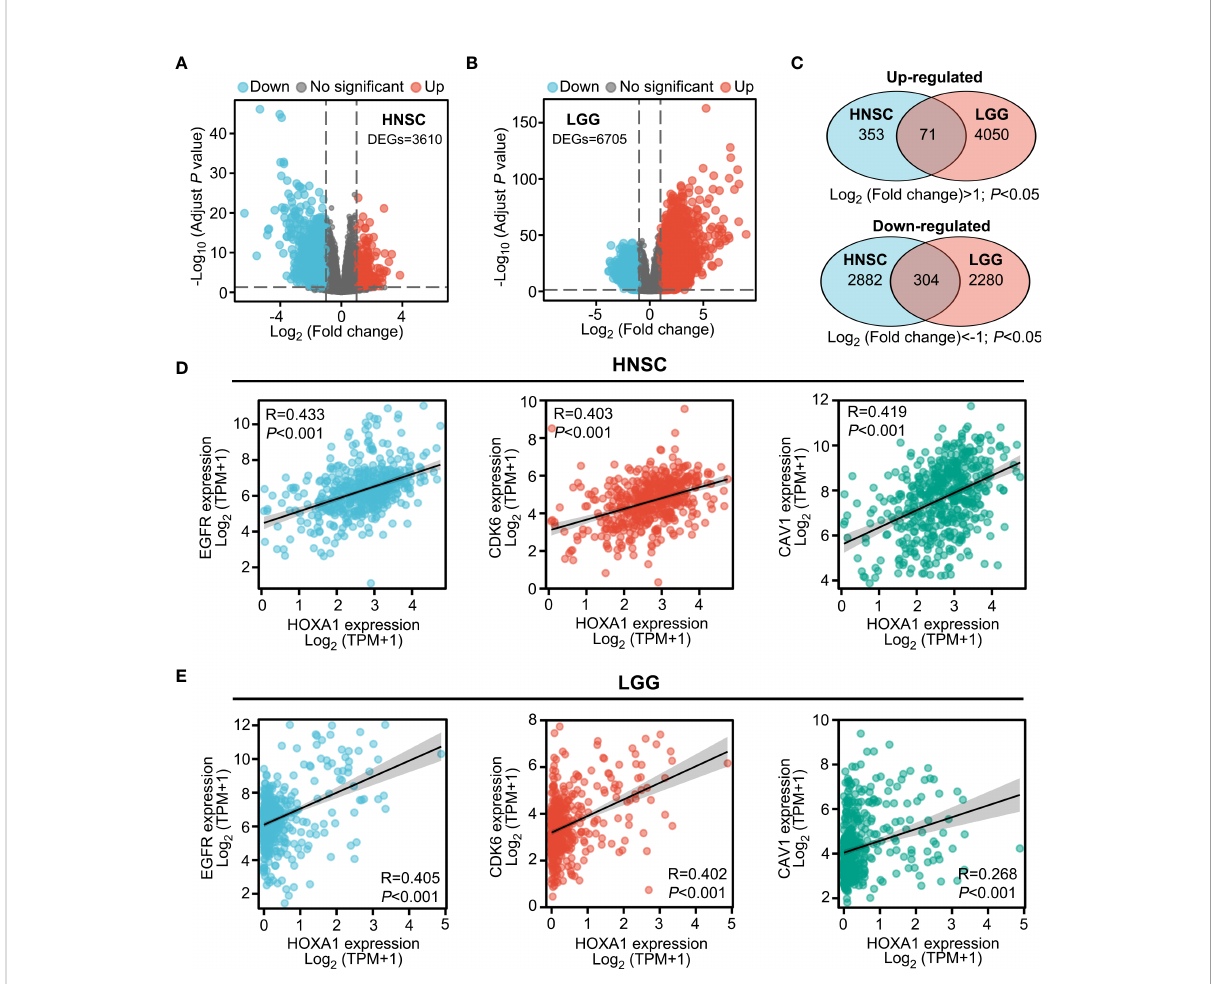
FIGURE 3 Transcriptomes of HNSCC and LGG tissues with varying HOXA1 expression. (A, B) Volcano plot showing the DEGs ( P < 0.05, log 2 fold change< − 1 or log 2 fold change >1) between high HOXA1 expression (top 25%) and low HOXA1 expression (bottom 25%) tumor tissue samples from HNSCC or LGG patients. (C) Venn plot depicting the overlapping genes with similar trends of expression changes in HNSCC and LGG samples with varying HOXA1 expression. (D) HOXA1 expression was signi fi cantly correlated with EGFR, CDK6, and CAV1 expression in HNSCC tissues. (E) HOXA1 expression was signi fi cantly correlated with EGFR, CDK6, and CAV1 expression in LGG